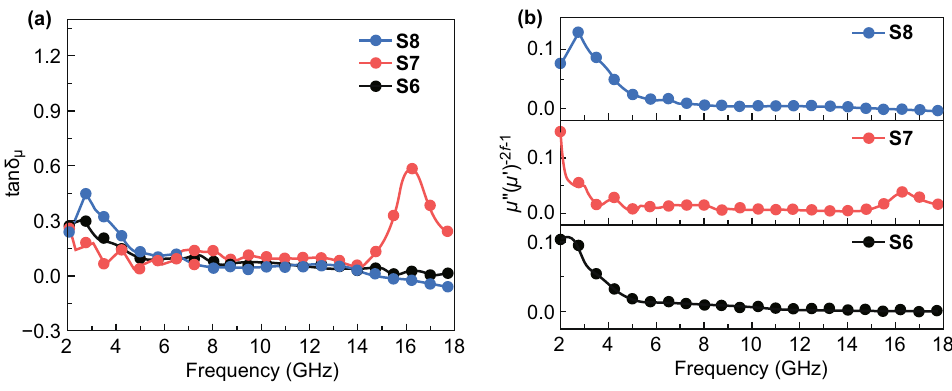
Fig. 6 a Magnetic loss tangent of S6, S7, and S8. b The calculated μ ′ (μ ″ ) −2 f −1 for S6, S7, and S8 at the frequency range of 2–18